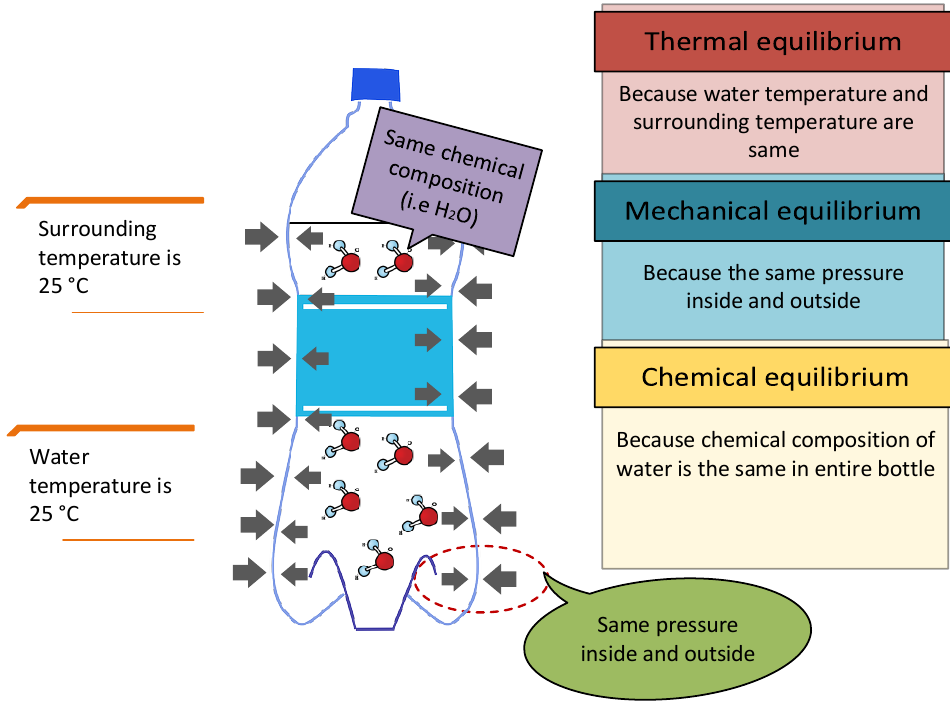
Figure 7. Absolute water equilibrium systems.